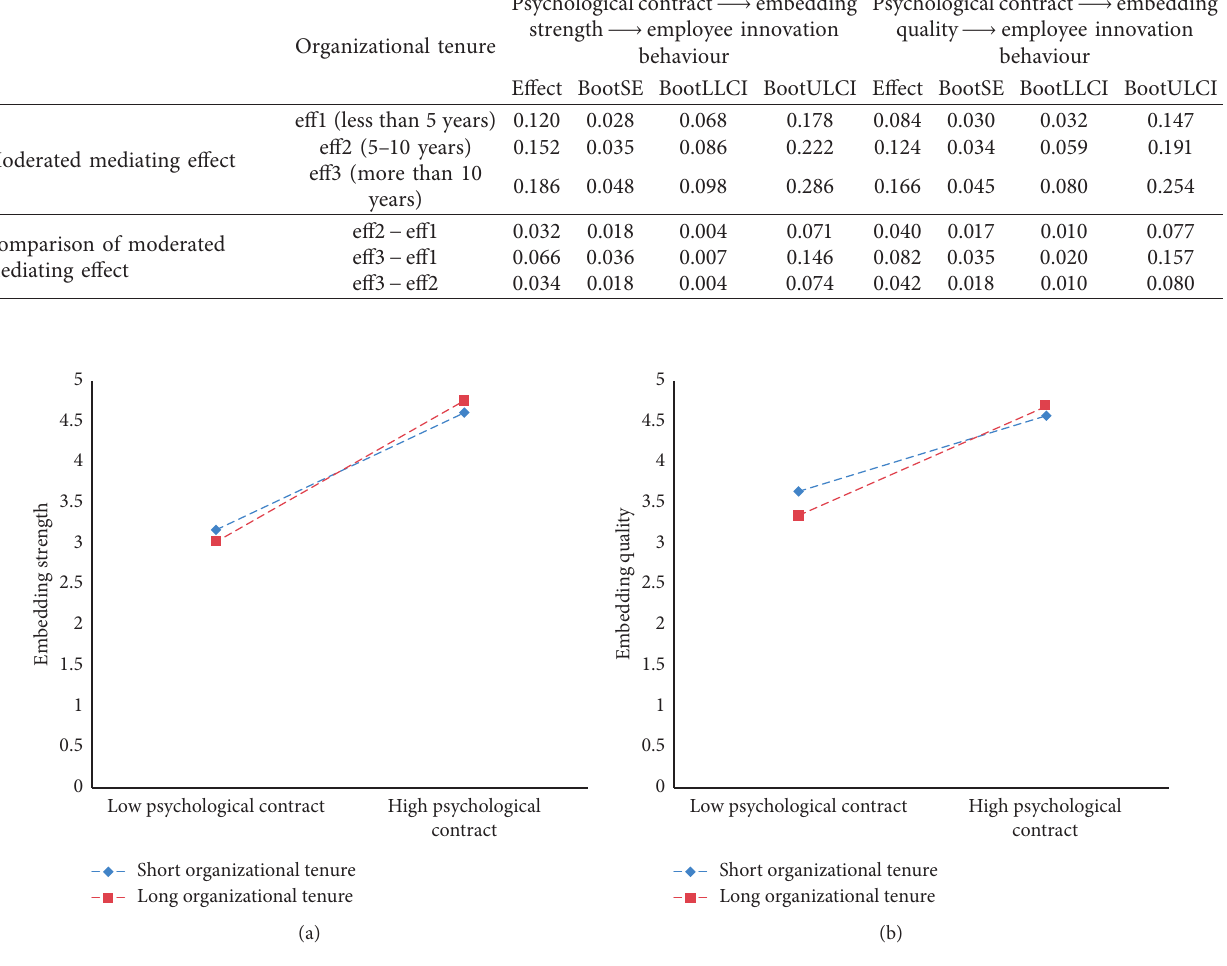
Figure 2: (a) Organizational tenure moderates the mediating path of psychological contract influencing employees’ innovative behaviour through embedding strength. (b) Organizational tenure moderates the mediating path of psychological contract influencing employees’ innovative behaviour through embedding